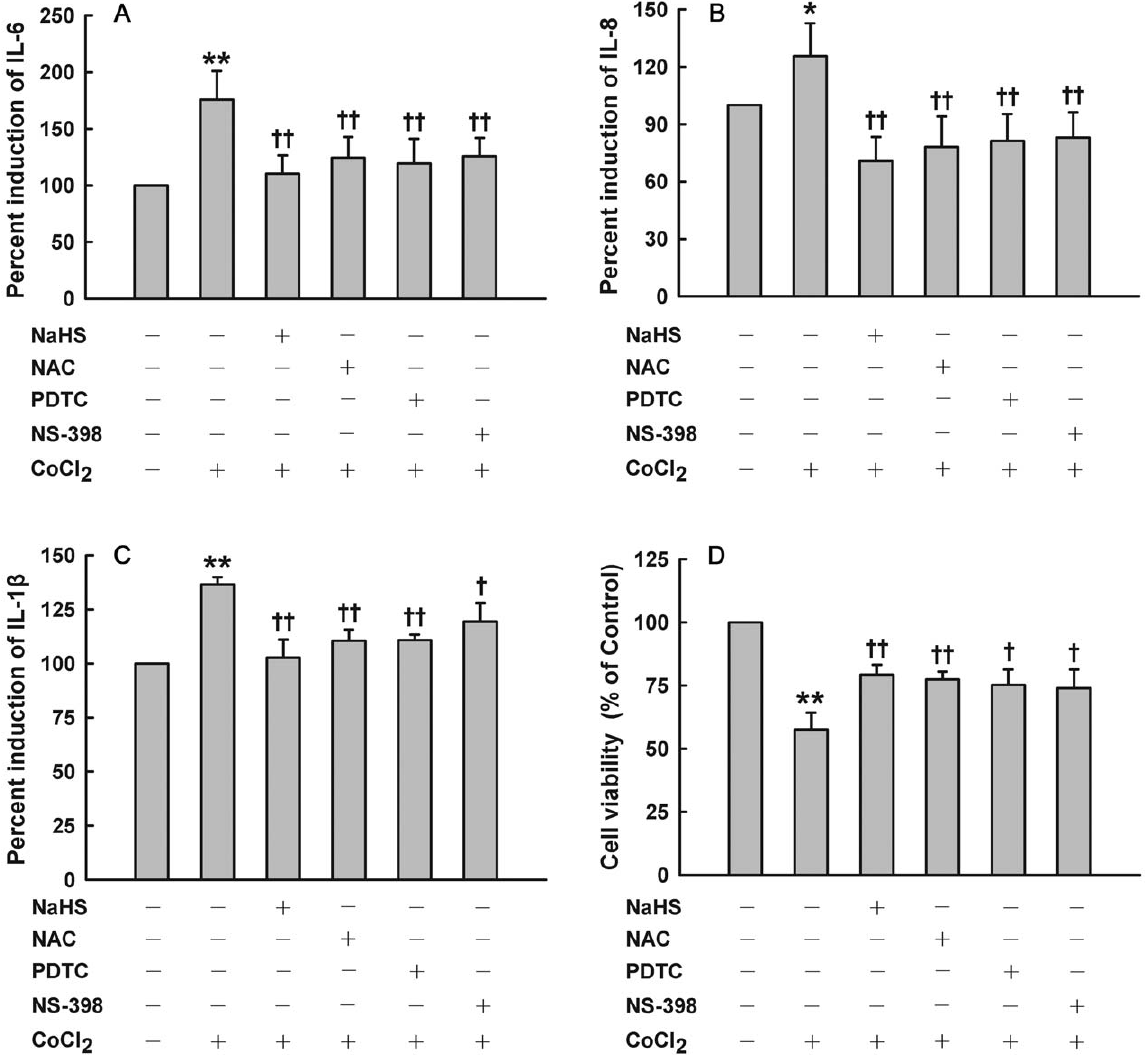
Figure 5. Effects of indicated treatments on secretions of IL-6, IL-8 and IL-1 b secretions as well as cytotoxicity induced by CoCl 2 in HaCaT cells. Before treatment with 500 m M CoCl 2 for 24 h, HaCaT cells were pretreated with 400 m M NaHS, 10 m M PDTC or 10 m M NS-398 for 30 min, or 1000 m M NAC for 60 min, respectively. IL-6 ( A ), IL-8 ( B ) and IL-1 b ( C ) secretions were detected by ELISA. ( D ) Cell viability was measured by CCK-8 assay. Data were shown as the mean 6 SE. * P , 0.05, ** P , 0.01 compared with control group. + P , 0.05, ++ P , 0.01 compared with CoCl 2 treatment group.